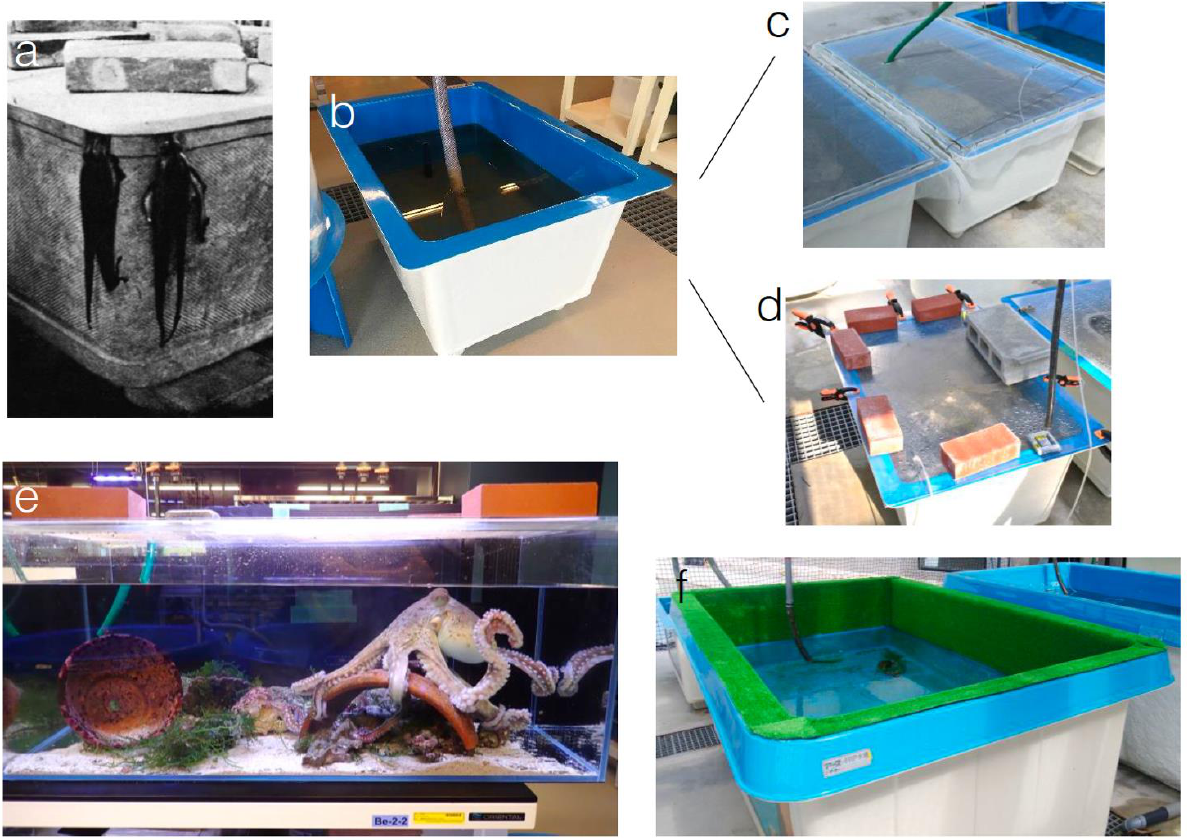
Figure 1. ( a ) Octopus vulgaris escapes, leading to animal loss [7]. ( b ) Type 1 tanks are standard 270 L aquaculture opaque tanks adapted for use with octopuses, with either ( c ) a net fastened into a rail, or ( d ) a weighted and clamped plexiglass lid. ( e ) Type 2 tank is a custom made 360 L plexiglass tank with weighted plexiglass lid. ( f ) Type 3 tanks are standard aquaculture 3000 L opaque tanks, with one plexiglass window, adapted for use with octopuses by lining upper interior walls and rim with artificial grass.